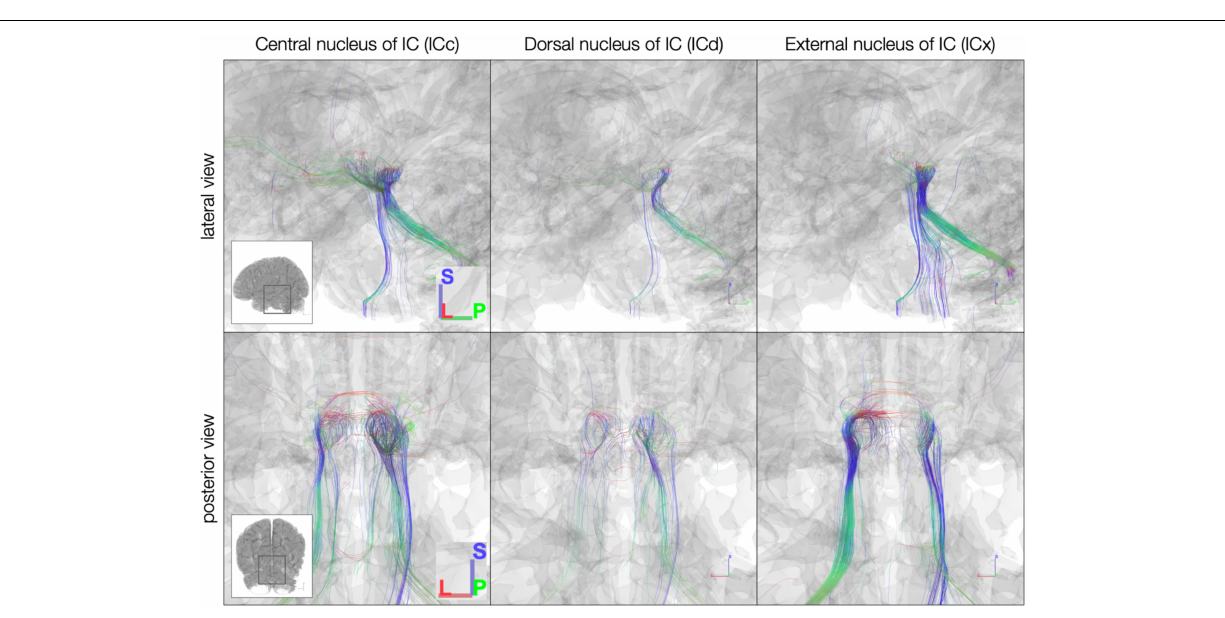
FIGURE 7 | In vivo anatomically defined inferior colliculus (IC) subdivision streamlines. Colors represent local streamline orientation: blue, superior–inferior; red, left–right; green,